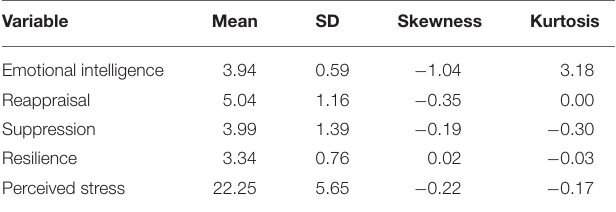
TABLE 2 | Descriptive statistics for emotional intelligence, reappraisal, suppression, resilience, and perceived stress.